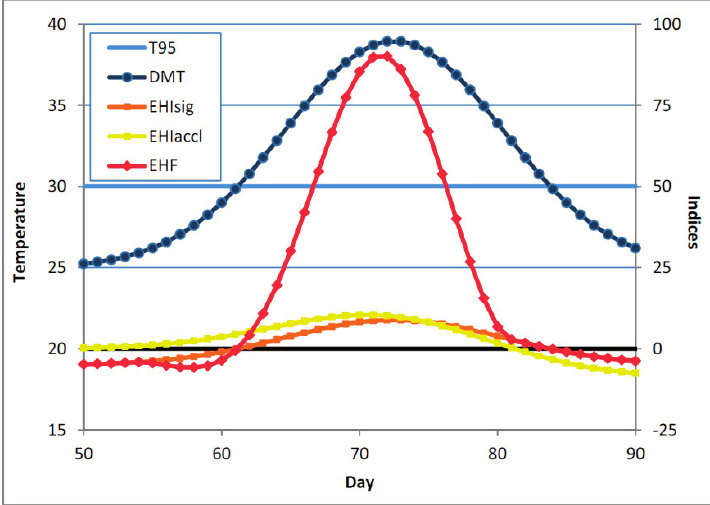
Figure 4. As per Figure 2, but for a long heatwave. Because of the length of the heatwave, the acclimatisation EHI can go negative before the end of the